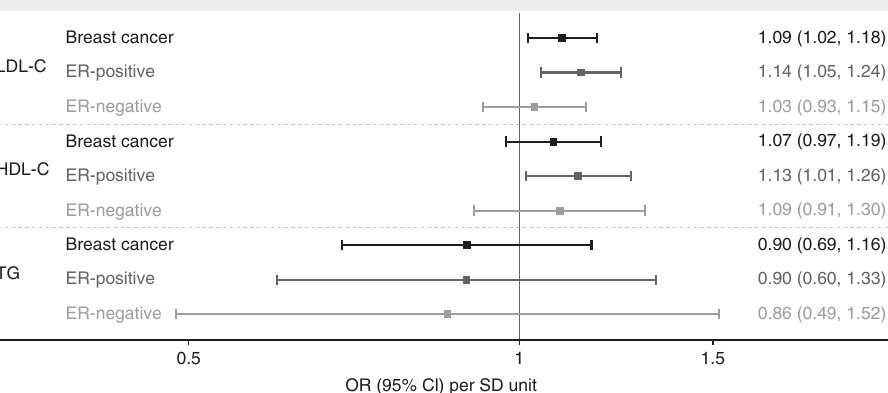
Fig. 2 Causal estimates of blood lipid levels on risk of all, ER-positive and ER-negative breast cancer. Inverse variance-weighted instrumental variable analysis using genome-wide signi fi cantly associated independent variants as instrumental variables for each lipid. Results following exclusion of variants associated at P < 0.001 with any of the other lipids and following removal of outlier variants ( P < 0.05 in MR-PRESSO) are shown. Causal estimates express the change in odds ratio (OR) per standard deviation (SD) increment in lipid concentration. Error bars indicate 95% con fi dence intervals